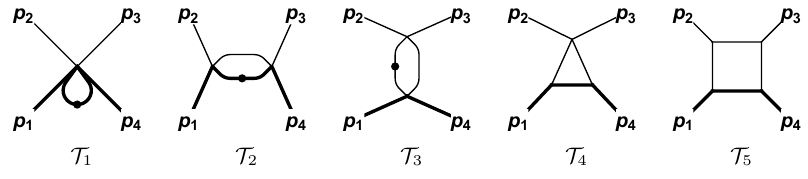
Figure 3. One-loop MIs T